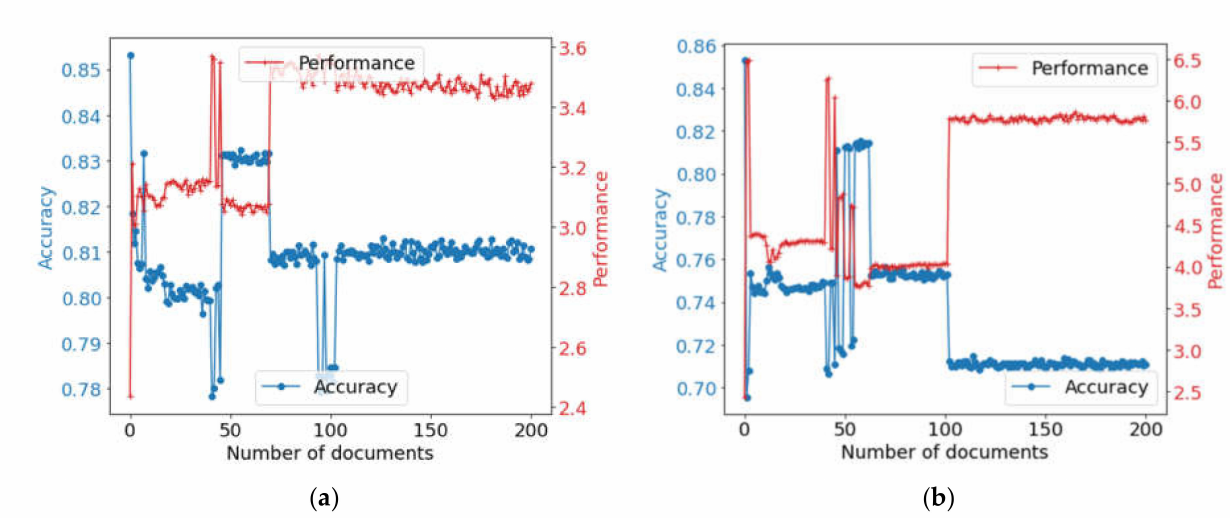
Figure 11. Case 4 auctioning results: ( a ) prioritization by accuracy, ( b ) prioritization by